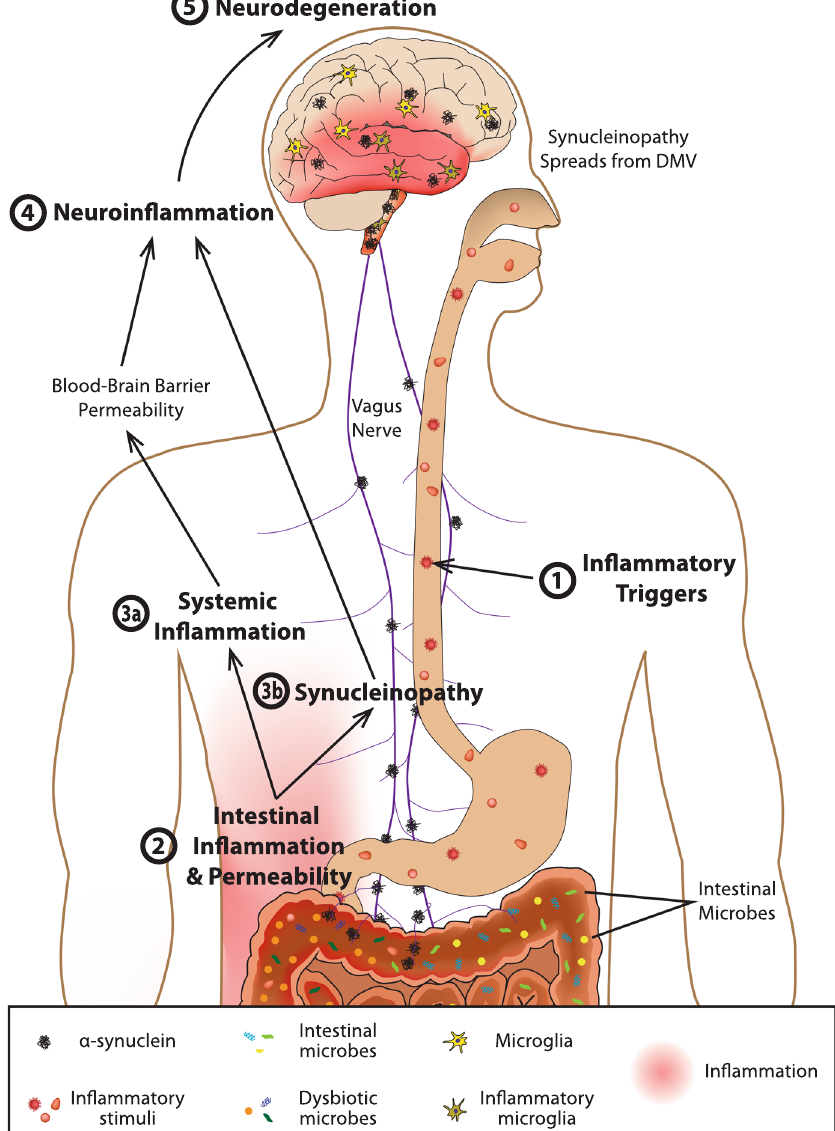
Fig. 1 Model of gut-originating, in fl ammation-driven PD pathogenesis. In a susceptible individual, in fl ammatory triggers (1) initiate immune responses in the gut that deleteriously impact the microbiota, increase intestinal permeability, and induce increased expression and aggregation of α SYN (2). Synucleinopathy may be transmitted from the gut to the brain via the vagus nerve (3b), and chronic intestinal in fl ammation and permeability promote systemic in fl ammation, which, among other things, can increase blood-brain barrier